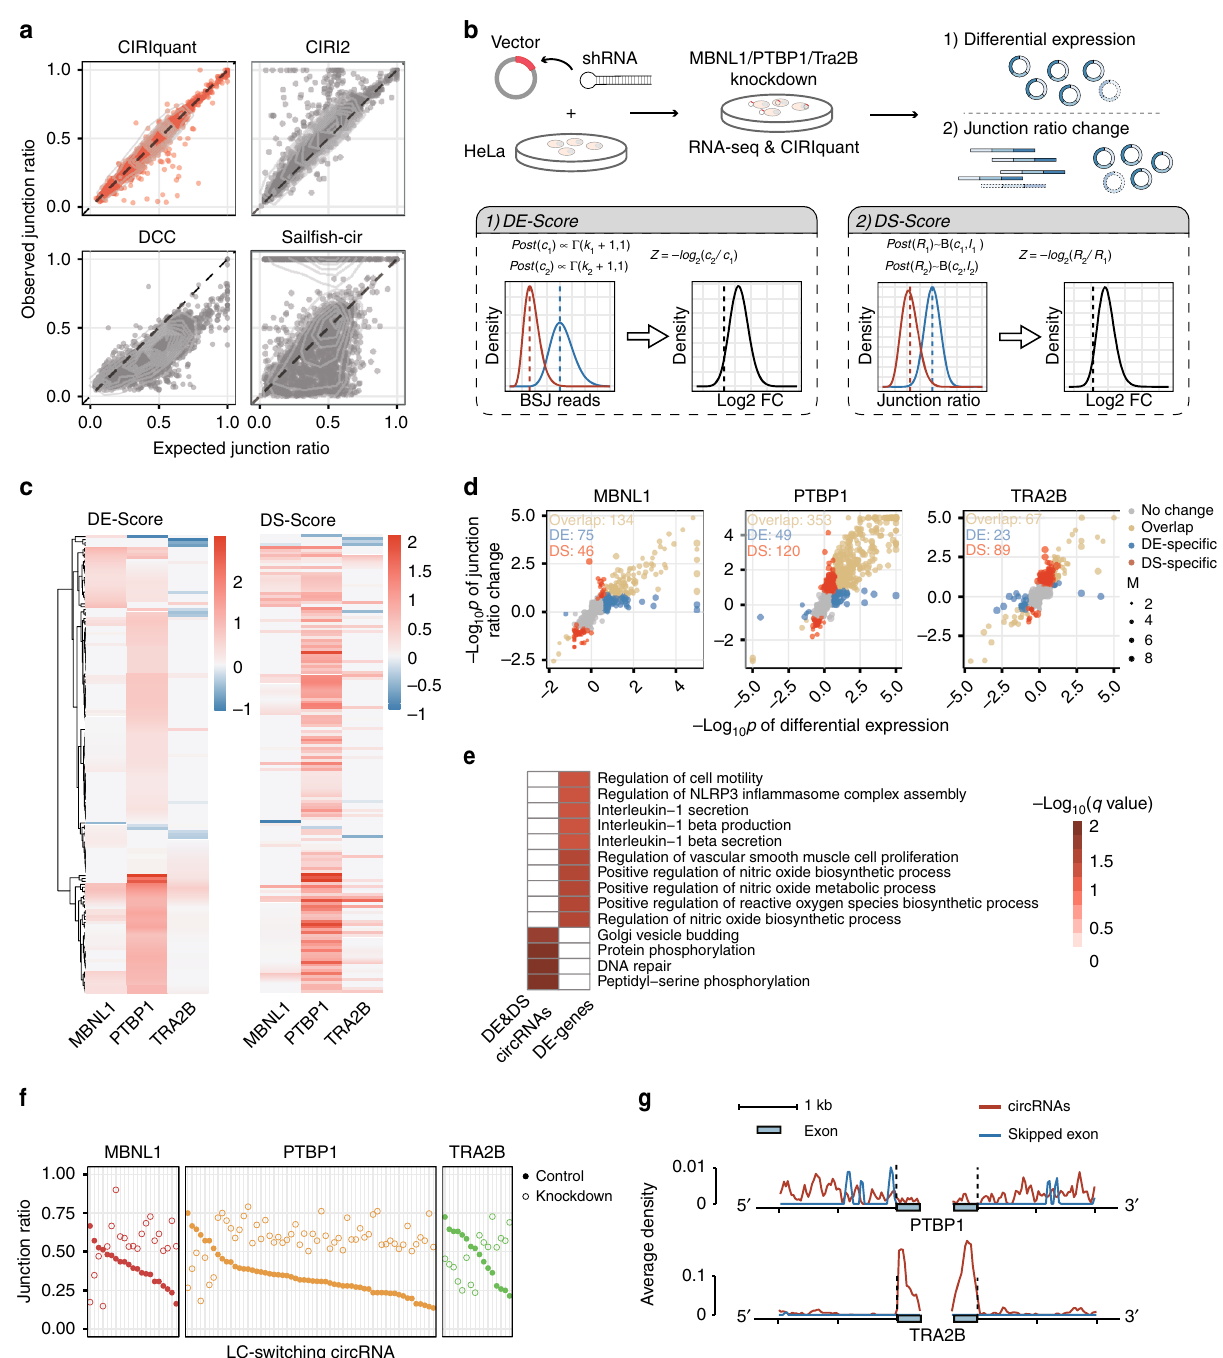
Fig. 5 Differentially spliced circRNAs after knockdown of three splicing factors. a The correlation between simulated and estimated junction ratio by CIRIquant and three other methods. x - and y -axis represent the expected and estimated junction ratio of circRNAs, respectively. For DCC, the junction ratio was calculated using the results from LinearCount and CircRNACount output. For Sail fi sh-cir, the TPM of circRNAs and corresponding host genes were used for junction ratio calculation. b Schematic view of experimental design for shRNA induced knockdown of three splicing factors (MBNL1, PTBP1, and Tra2B) and the calculation of DE- and DS- score. Specially designed shRNAs were used to knockdown target genes. Then, RNA-seq were performed for control and knockdown groups, and circRNA expression levels and junction ratio were estimated by CIRIquant for further differential expression analysis. c Heatmap of DE score and DS score in three knockdown datasets. Only circRNAs signi fi cantly changed in at least one sample are shown in the heatmap. d Overlap of signi fi cantly changed circRNAs. x - and y -axis represent − log10( p value) from DE-analysis and rate-ratio test using junction ratio of circRNAs in two different conditions, respectively. Downregulated p -values are assigned as negative values. DE-speci fi c and DS-speci fi c circRNAs are highlighted in blue and red, respectively. e Gene ontology enrichment analysis of differentially expression genes and all signi fi cantly changed DE- and DS-circRNAs. The logarithm of FDR was calculated in Enrichr, then plotted in heatmap for comparison. f Junction ratio changes of LC-switching circRNAs after MBNL1/PTBP1/TRA2B knockdown. g Average depth of binding sites in fl anking regions of differentially spliced ES exons and signi fi cantly changed circRNAs using CLIP-seq results from iCLIPdb. A sliding window analysis with 8 bp windows was performed for density calculation. Vertical axis represents the average binding site per shifted